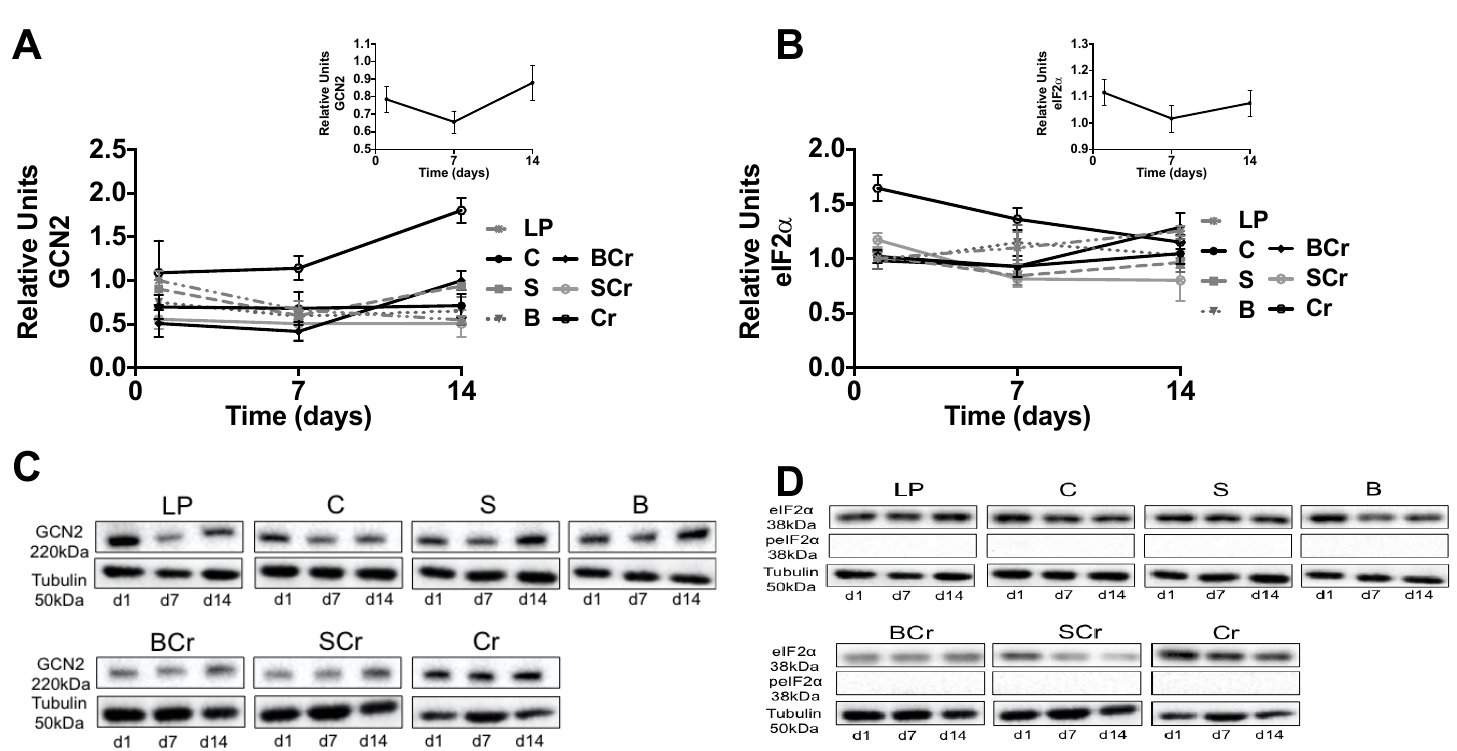
Figure 7. Western blot analysis and quantification of GCN2 and eIF2 α in liver of rats fed different types of proteins after a protein restricted period: ( A ) representative Western blot analysis of GCN2 and ( B ) eIF2 α ; ( C ) protein abundance of GCN2; and ( D ) protein abundance of eIF2 α . Values are means ± SEM, n = 3, p < 0.05, a > b > c.